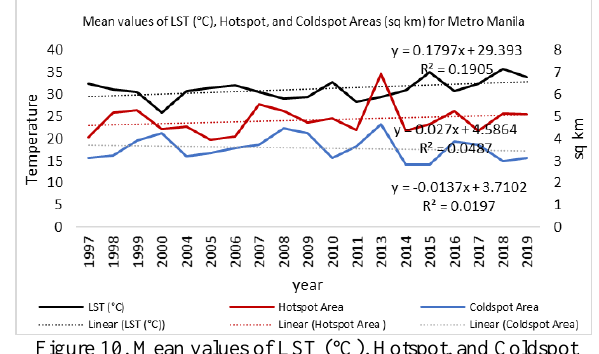
Figure 10. Mean values of LST (°C), Hotspot, and Coldspot Areas (km 2 ) for Metro Manila.